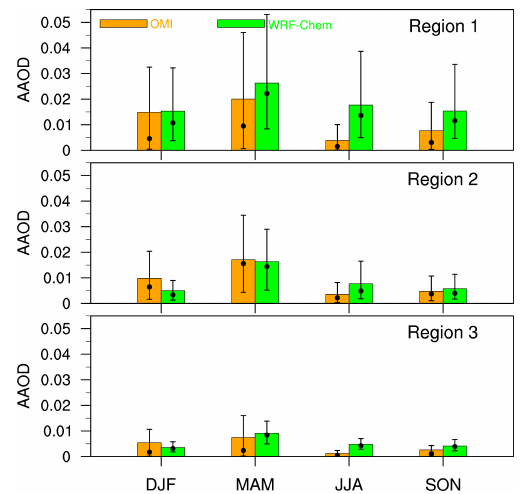
Figure 9. Seasonal mean AAOD at 500nm from the OMI retrievals and the corresponding WRF-Chem simulation averaged for the pe- riod 2010–2014 over the three sub-regions shown in Fig. 4. The values of bars represent the mean. The vertical lines represent 10th and 90th percentile values, and the black dots represent the median